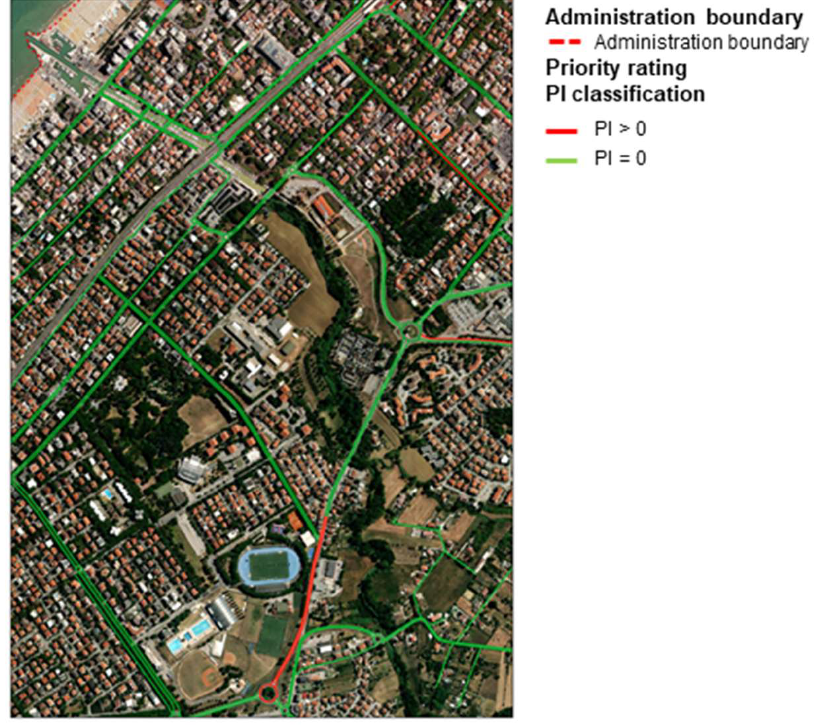
Figure 8. Example of GIS mapping of the priority rating (PI classification).